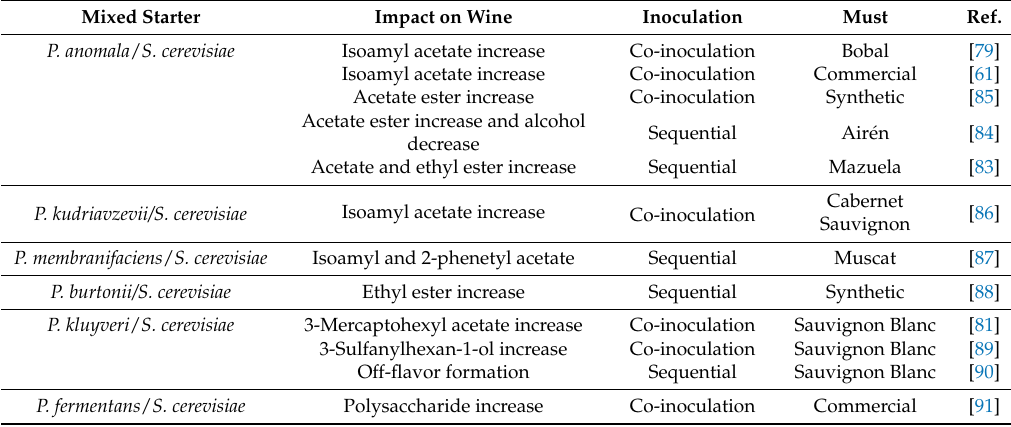
Table 1. Mixed starters of Pichia species and their main impact on wine